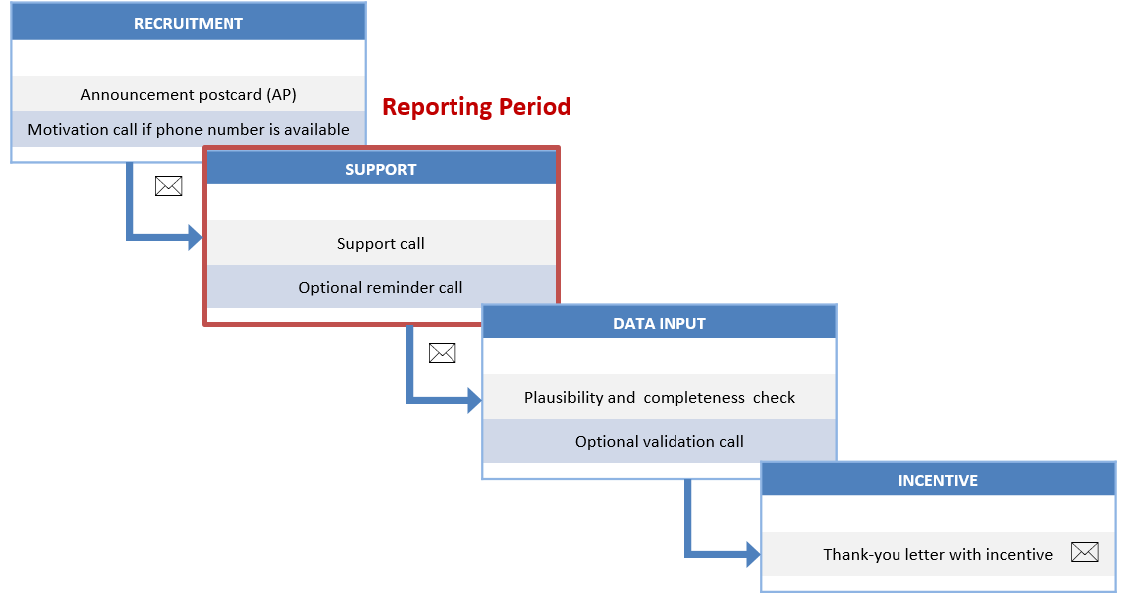
Figure 1. Survey procedure of the MAED-survey Austrian National Travel Survey